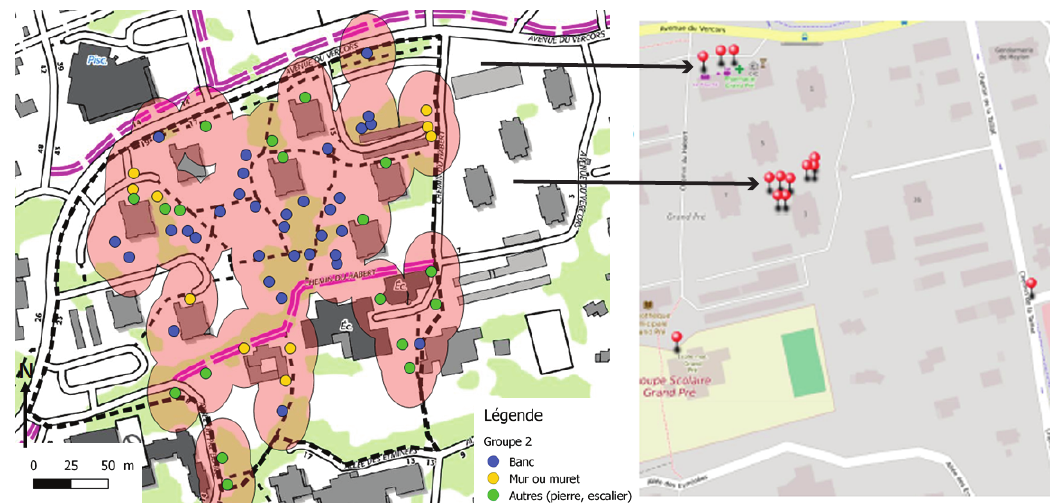
Figure 3. A French neighbourhood with benches, sector 1, on left (blue spots); sector 2, on right, with 2 concentrations of benches (red points).